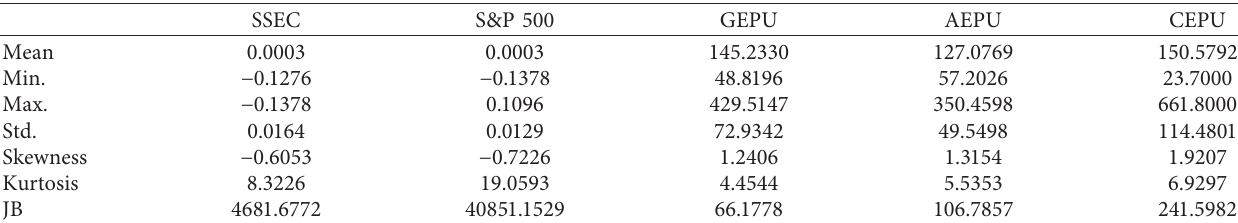
Table 2: Descriptive statistics of daily SSEC and S&P 500 index returns as well as monthly GEPU, AEPU, and CEPU indices.